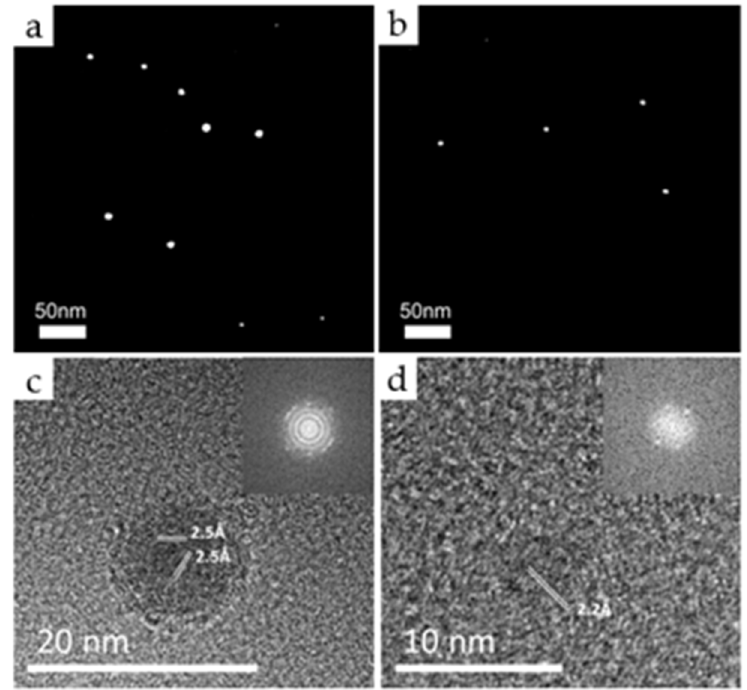
Figure 7. Transmission electron microscope (TEM) images of carbon nanoparticles captured for 15 s on the SiO membrane of the TEM grid. ( a , b ) show the scanning TEM (STEM) images of nanoparticles captured at 1900 ◦ C and 2100 ◦ C, respectively, at 3% CH 4 –97% H 2 . ( c , d ) show high resolution TEM (HRTEM) images of nanoparticles, respectively, of ( a , b